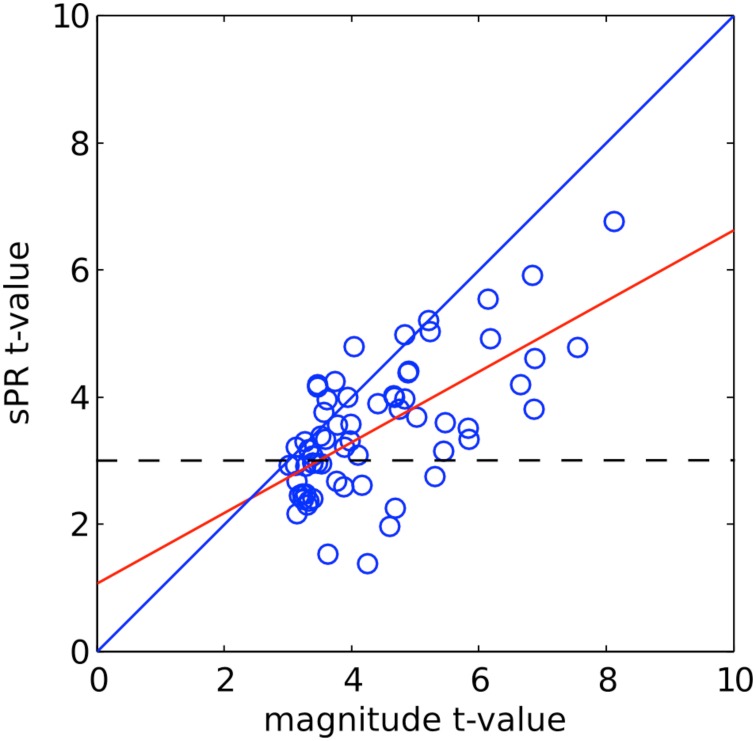
sPR t-values plotted against magnitude t-values for right PPA voxels of one typical subject. The linear fit is shown in red. The dashed line shows the significance level (t > 3, p < 0.005). Many high magnitude t-valued voxels are reduced by large vein suppression but remain significant.